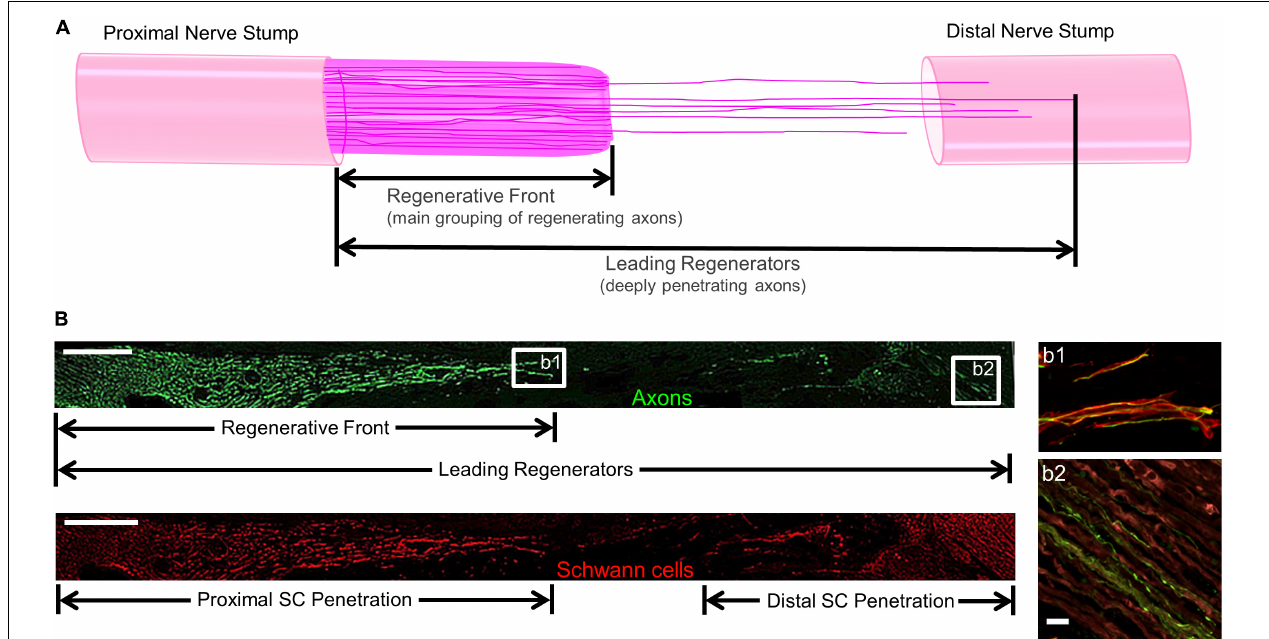
FIGURE 2 | Methods to Quantify Axon Regeneration and Schwann Cell (SC) Infiltration. (A) Cartoon depicting the staggered process of acute axonal regeneration across a segmental nerve lesion, where the main bolus of regenerating axons – termed the “Regenerative Front” – is preceded by an accelerated, but less dense, population of regenerating axons – termed the “Leading Regenerators.” These 2 populations of regenerating axons were measured for each animal at 2 weeks following repair of 1 cm segmental defects by quantifying the distance from the proximal end of the repair zone to the distal axonal projections, with multiple sections surveyed per animal to ensure that the maximal values were attained. (B) Examples of longitudinal tissue section of nerve regeneration across a 1.0 cm sciatic nerve gap (repaired by a TENG), with the repair zone beginning proximally on the left and proceeding distally to the right. ( B , top) Example of axon regeneration measurements: neurofilament labeled with SMI31, and the measurements of the “Regenerative Front” and “Leading Regenerator” axons are denoted. Scale bar: 1000 µ m. ( B , bottom) Example of SC infiltration measurements: SCs are labeled with S100, and the measurements of both the proximal and distal infiltration are shown. Scale bar: 1000 µ m. (b1) “Regenerative Front” showing colocalization of axons and SCs. (b2) “Leading Regenerator” axons found beyond the repair zone, within the distal stump. (b1,b2) Scale bar: 20 µ